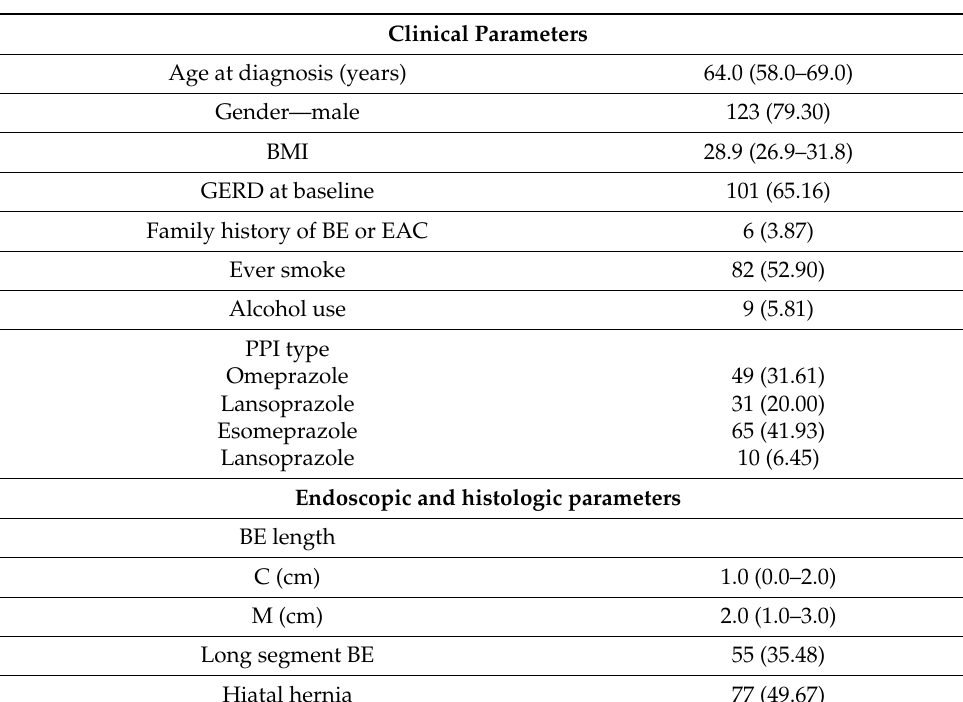
Figure 1. Study flow chart. NDBE—nondysplastic Barrett’s esophagus. Figure 1. Study fl ow chart. NDBE—nondysplastic Barre tt ’s esophagus. Table 1. Baseline characteristics of the study cohort; N = Table 1. Baseline characteristics of the study cohort; N = 155.